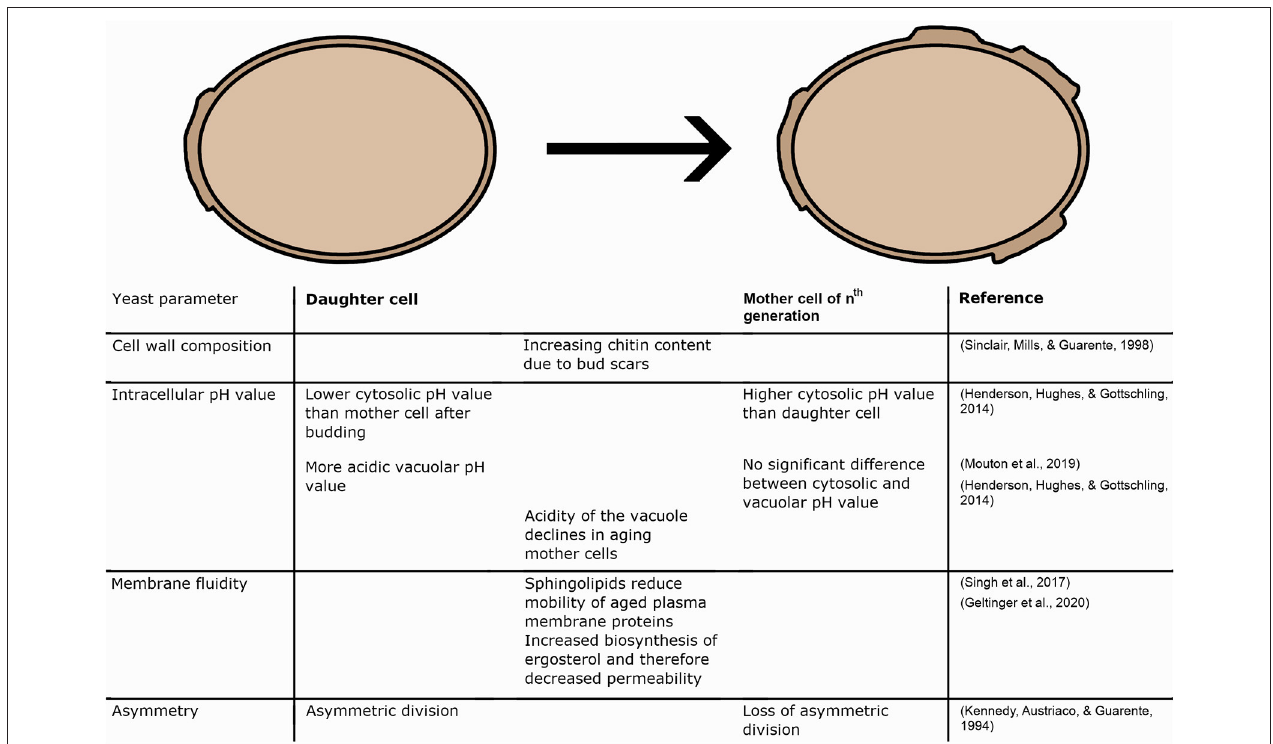
FIGURE 4 | Illustration of different intracellular changes in daughter cells, mother cells, and changes during the aging process.